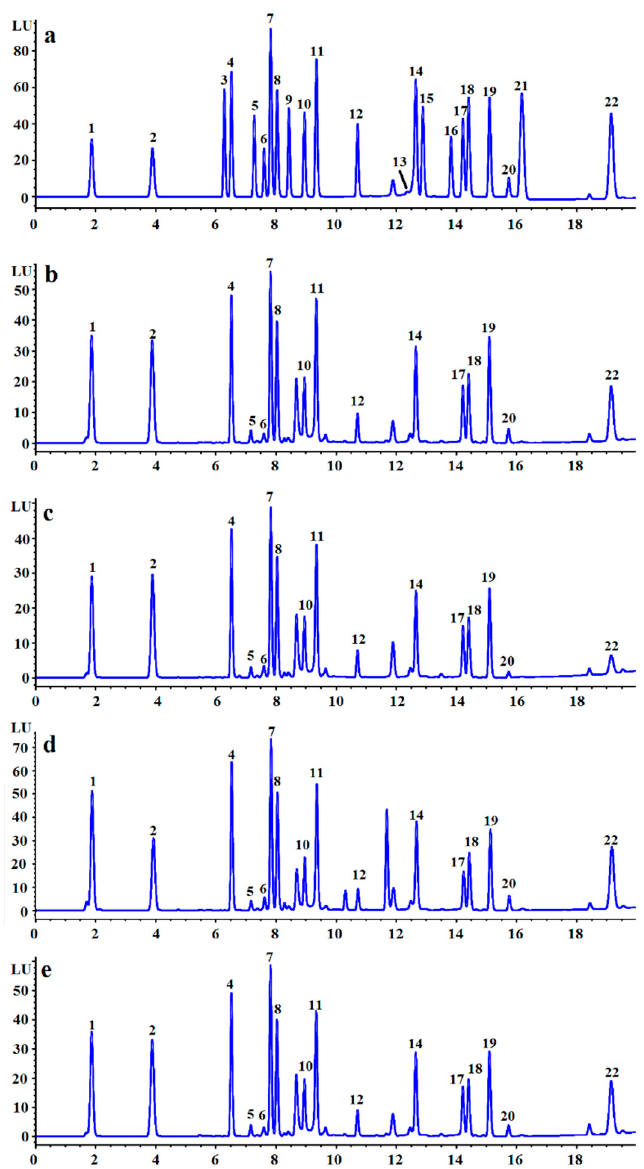
Figure 3. HPLC chromatograms of amino acid compositions of mixed standards and LVPs extracted by different methods: ( a ) mixed standards; ( b ) LVP-u; ( c ) LVP-m; ( d ) LVP-e; ( e ) LVP-h. The peaks identified are (1) asparaginic acid, (2) glutamic acid, (3) asparagine, (4) serine, (5) glutamine, (6)